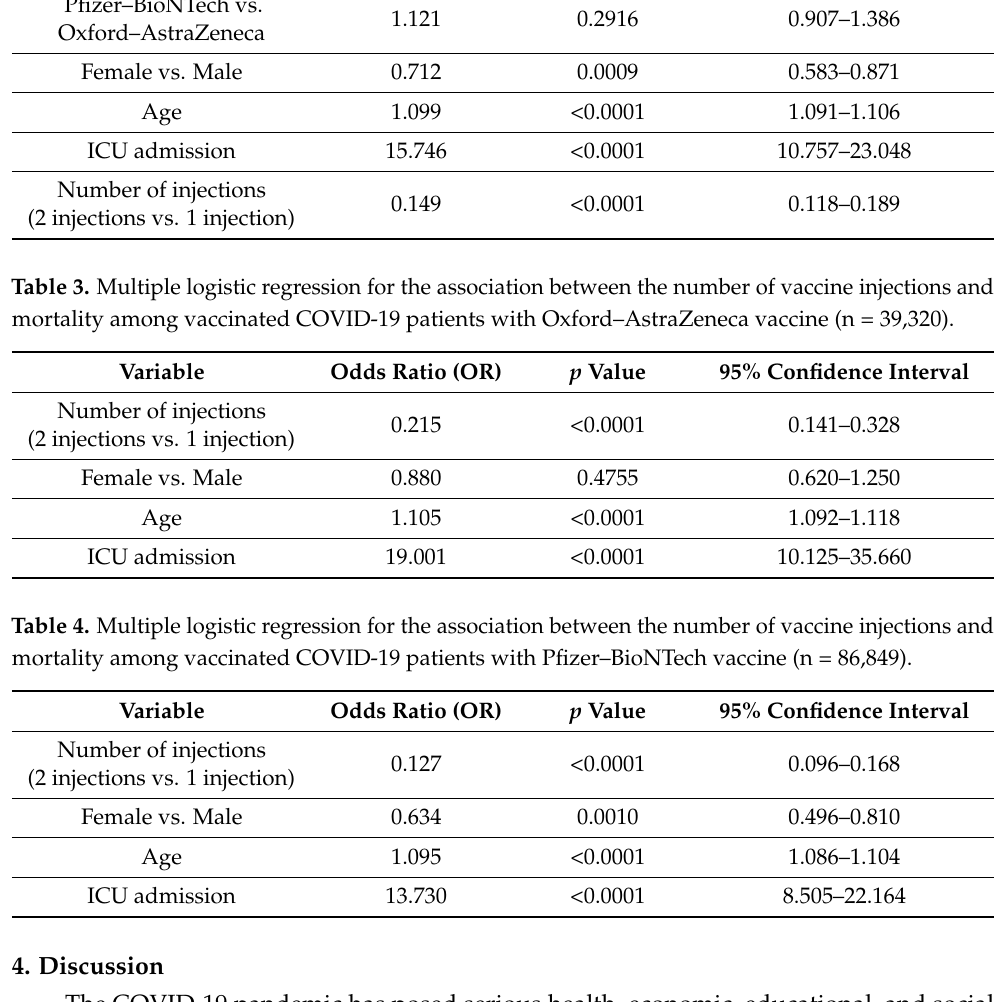
Table 2. Multiple logistic regression for the association between the administration of vaccines (Oxford n = 39,320 vs. Pfizer n = 86,849) and mortality among COVID-19 patients vaccinated prior to infection (n = 126,169). Odds Ratio (OR) p Value 95% Confidence Interval Pfizer–BioNTech vs.